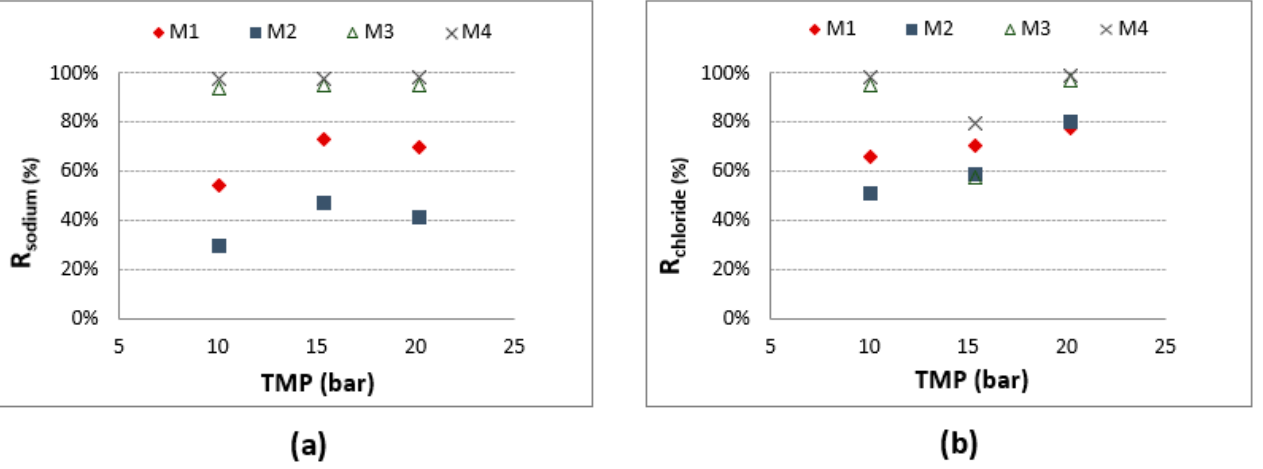
Figure 6. Influence of TMP on sodium ion ( a ) and chloride ion ( b ) retention at CFV = 0.89 m · s − 1 for the tested membranes.